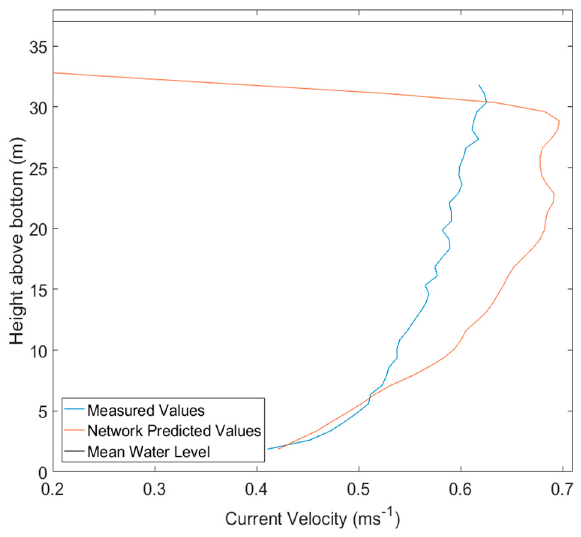
Figure 9. Velocity profile at ADCP-E, trained by SCG method using ADCP-W. Blue: measured values, and orange: network prediction.